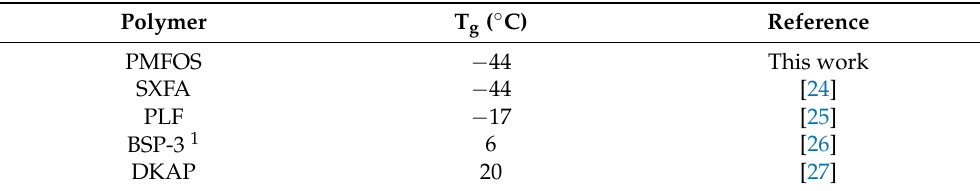
Table 1. Comparison of glass transition temperatures (T g ) of selected HBA polymers used in gas sensors.